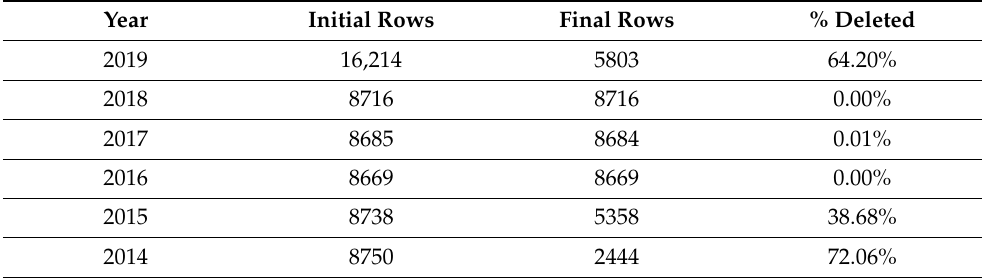
Table 3. Results of the cleaning process for each year.